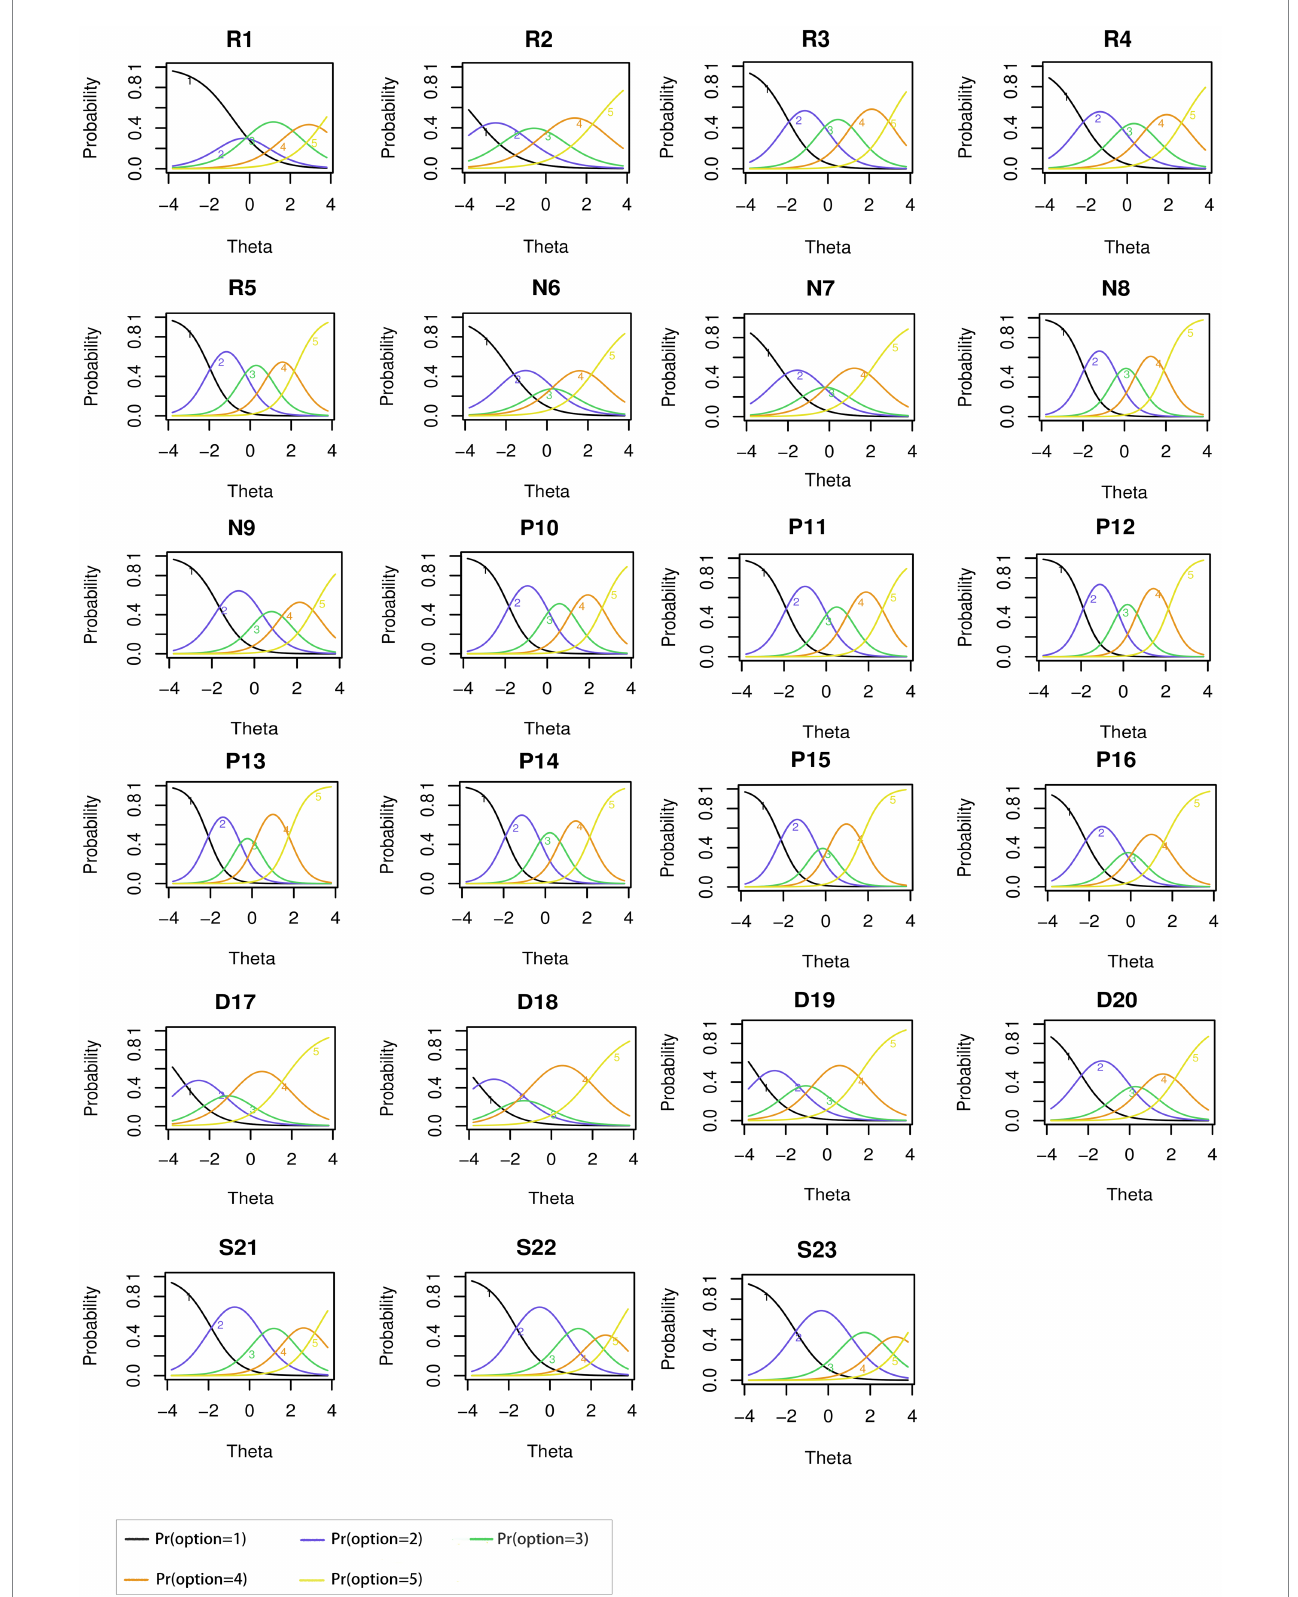
FIGURE 2 Item response category characteristic curves of all items in hepatitis B virus infection-related stigma scale